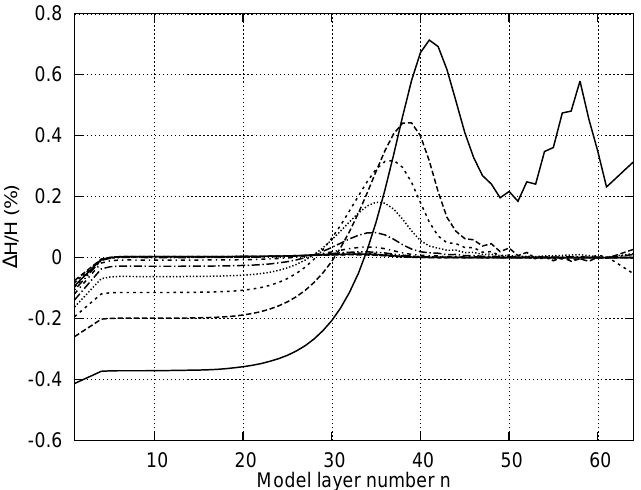
Fig. 3. Zoomed Figure 2, from where the initial model atmosphere flux has been removed. The deviations (in %) of the stellar model atmosphere flux, obtained using the Jacobian computed by the first cycle of the Levenberg-Marquardt method (solid line) and in its consequent iterative improvement by the Broyden loop steps. The model parameters: T eff = 16 000 K, log g =